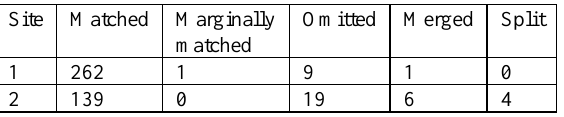
Table 3: The accuracy statistics of the delineation tree crowns using attention U-net for test sites 1 and 2. The total number of reference crowns are 273 and 168 for these two sites, respectively.